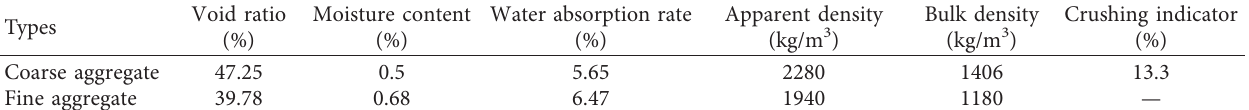
Table 1: Performance indexes of recycled aggregate.